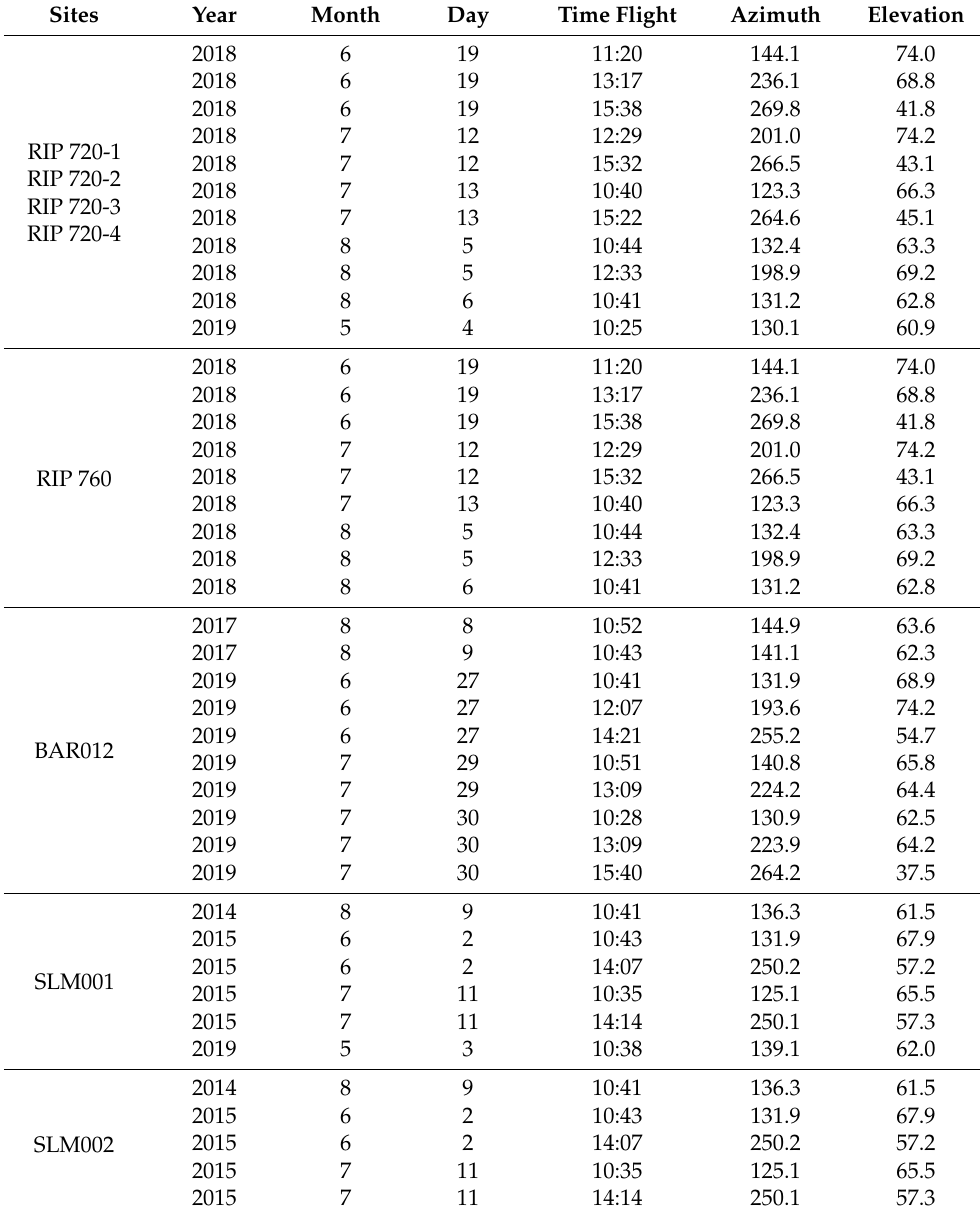
Table A2. The flight date and time of the sUAS platform over vineyards. Azimuth and elevation of the sun corresponding to the time are also